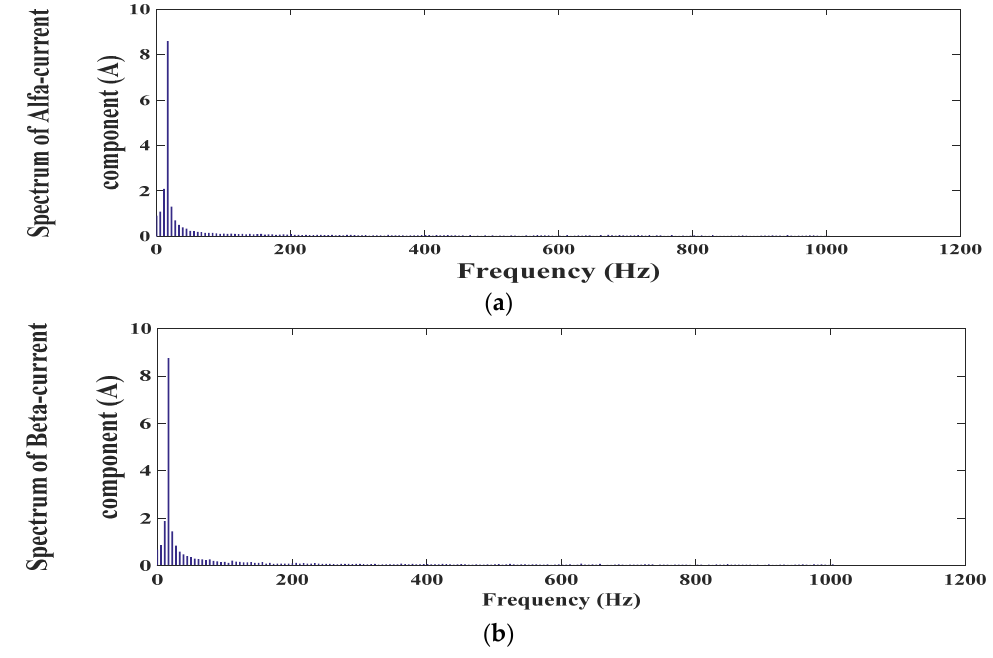
Figure 21. ( a ). FFT spectrum of α -component of stator current for proposed PVC, ( b ). FFT spectrum of β -component of stator current for proposed PVC.